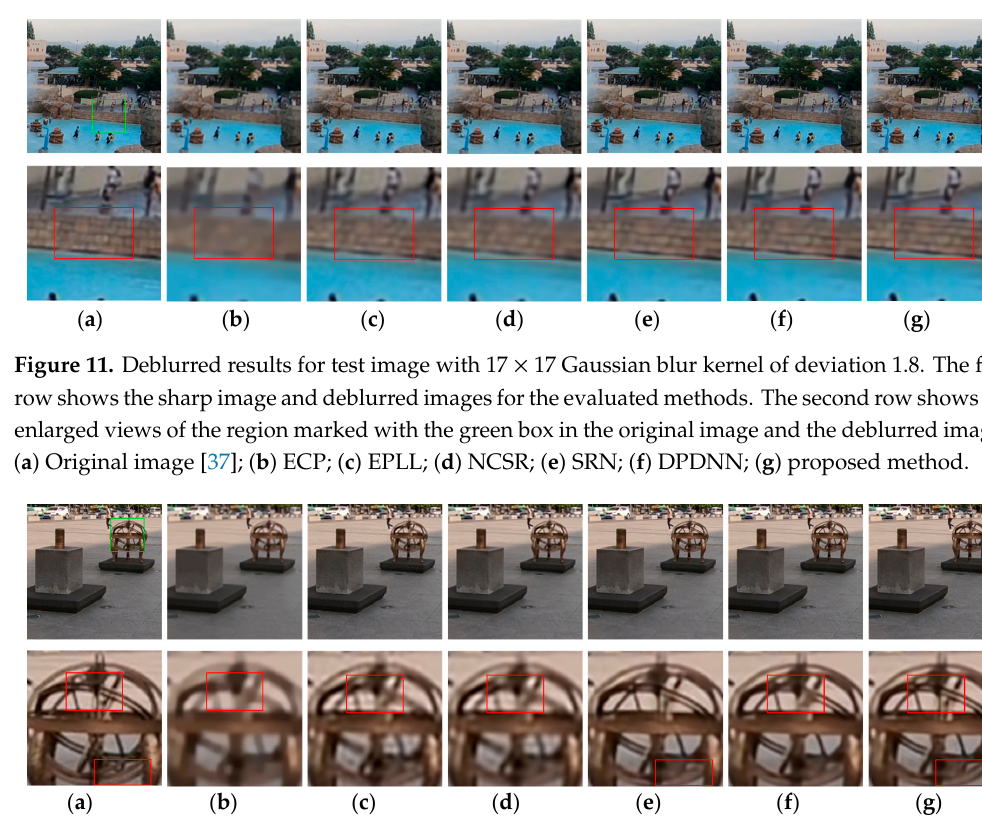
Figure 10. Difference images between the region marked with the green box in Figure 9a and its deblurred results. ( a ) ECP; ( b ) EPLL; ( c ) NCSR; ( d ) SRN; ( e ) DPDNN; ( f ) proposed method. Sensors 2020 , 20, x FOR PEER REVIEW